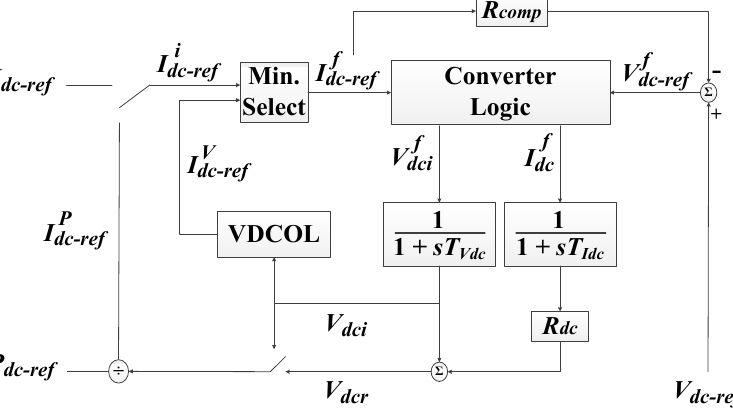
Figure 1. A control diagram for the CDC4T and CDC6T.